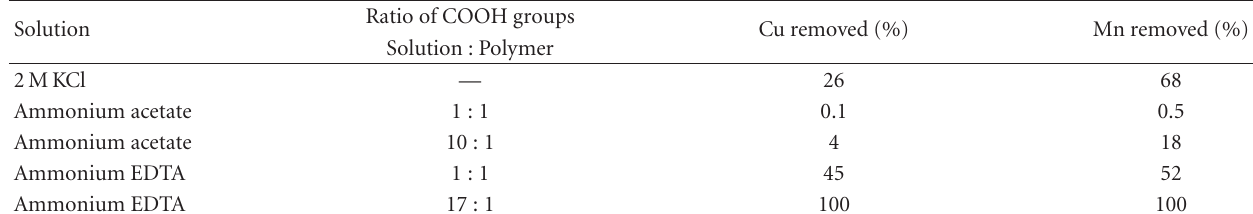
Table 1: Copper and manganese removed from a polyacrylate polymer ∗ with di ff erent solutions.